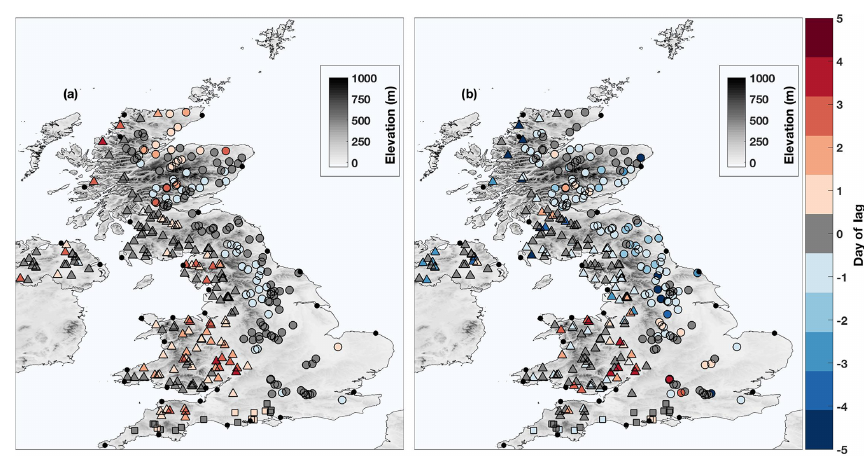
Figure 6. (a) The lag day when Kendall’s rank correlation τ is maximum between daily maximum skew surge and daily maximum river discharge and (b) the lag day when the number of joint occurrences between high skew surge and high river discharge is maximum. Note that the triangles, circles, and squares show the river stations that discharge onto the western, eastern, and southern coasts, respectively.